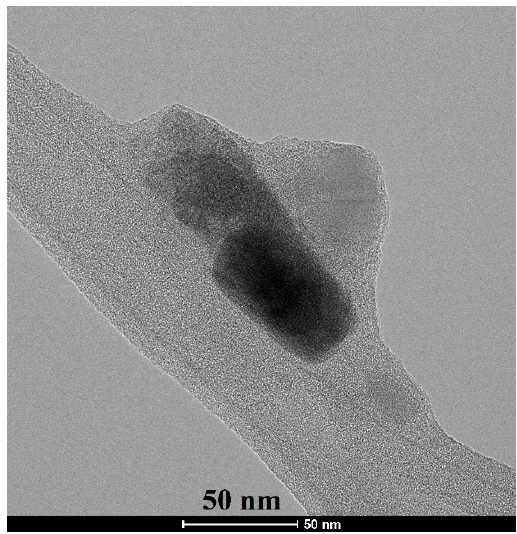
Figure 6. TEM micrograph of akermanite powder produced after 20 h ball milling of the initial materials with subsequent annealing at 900 °C for 1 h.